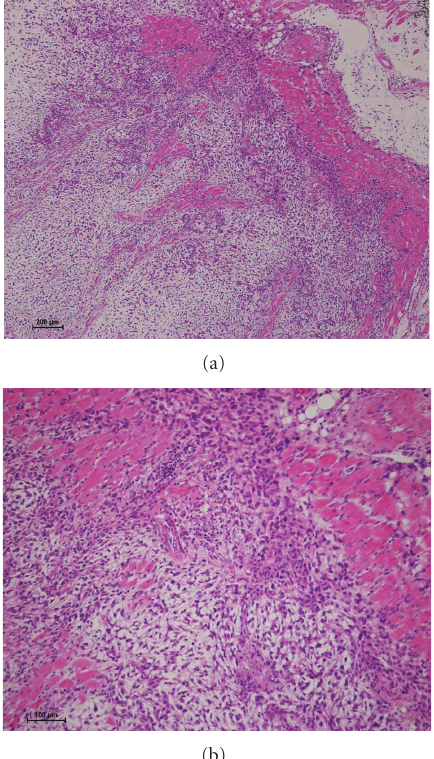
Figure 2: Hematoxylin and eosin stain × 40 (a) and × 100 (b). Biopsy of the tumor showed a typical histology of myxofibrosar- coma. The histological grade was determined as grade 1.